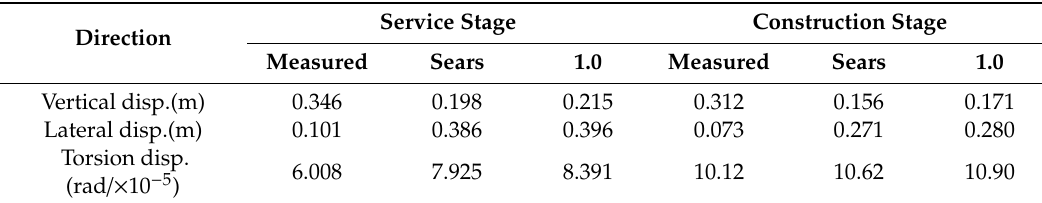
Table 8. RMS maximum value of mid-span in the service and construction